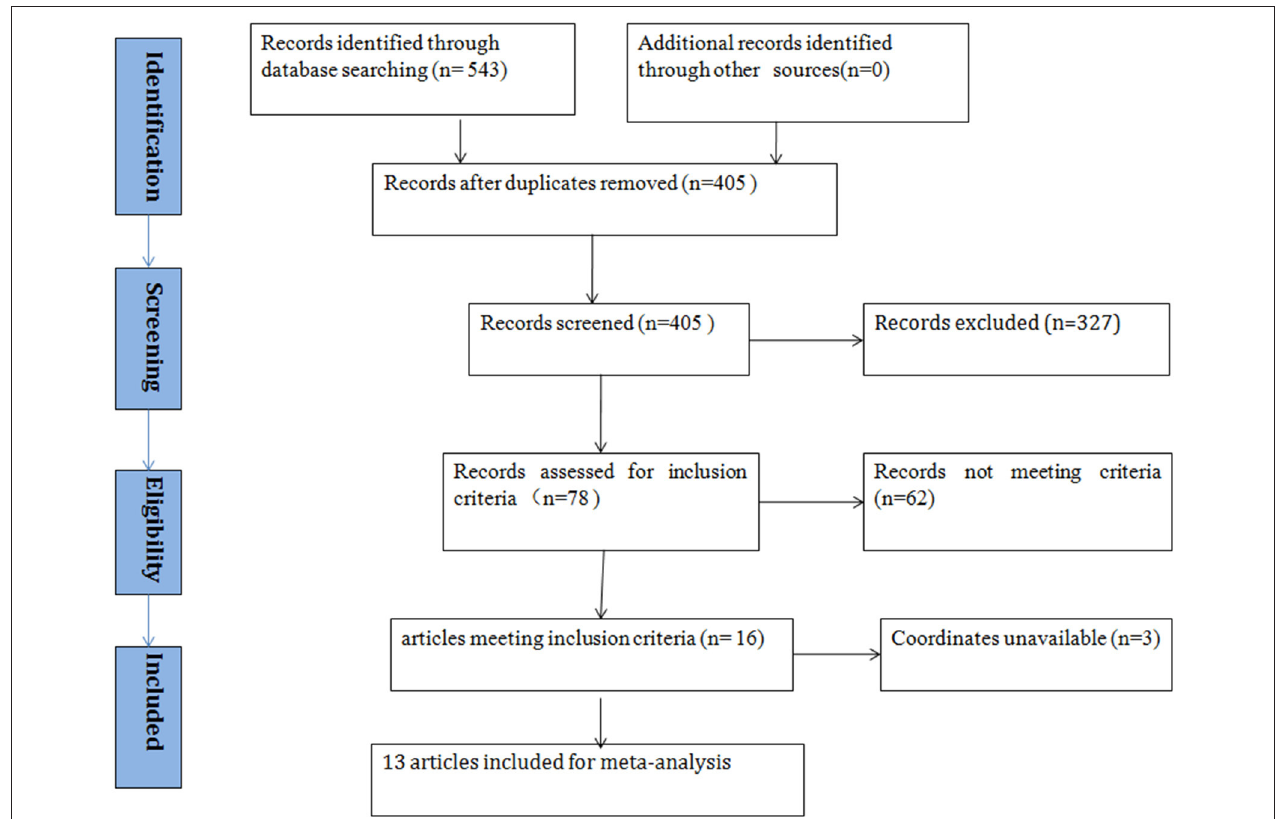
FIGURE 1 | Meta-analysis of resting-state brain activity studies of patients with ASD.